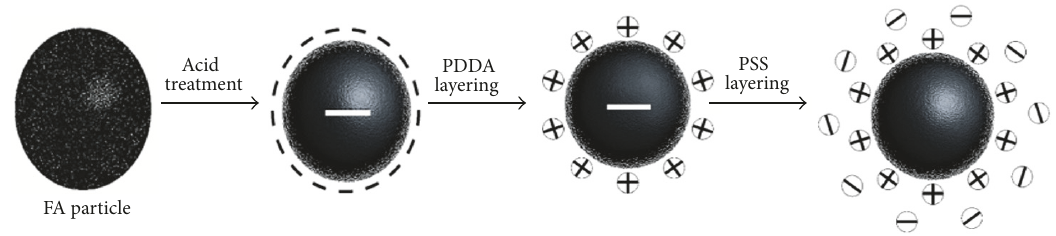
Figure 2: Schematic illustration of acid treatment and polyelectrolytes coating of fly ash